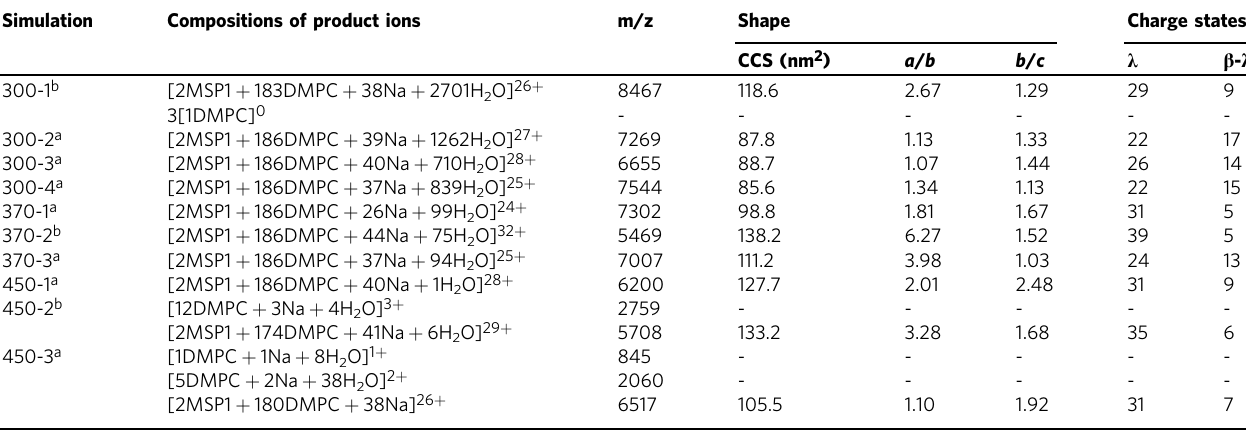
Table 1 Properties of all product gaseous